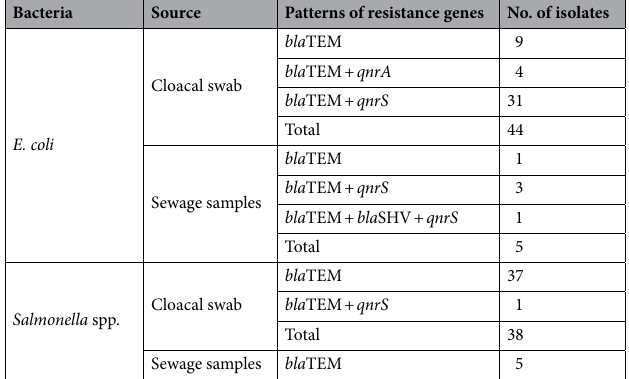
Bacteria Source Patterns of resistance genes No. of isolates